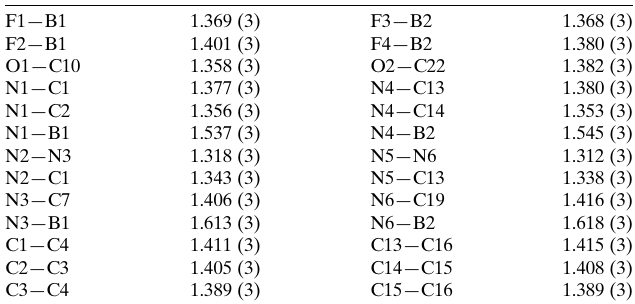
Table 2), forming a one-dimensional ladder-like structure